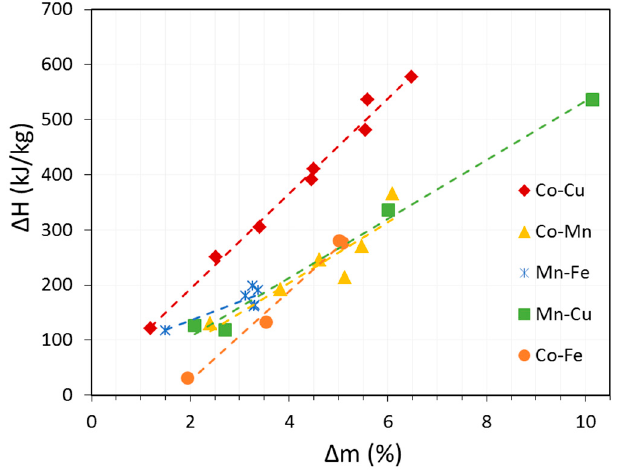
Figure 2. Correlation between measured enthalpy (average values from the reduction and oxidation reactions) and OSC ( Δ m) of Co-Fe, Co-Cu, Mn-Co, Mn-Fe and Mn-Cu mixed oxides.